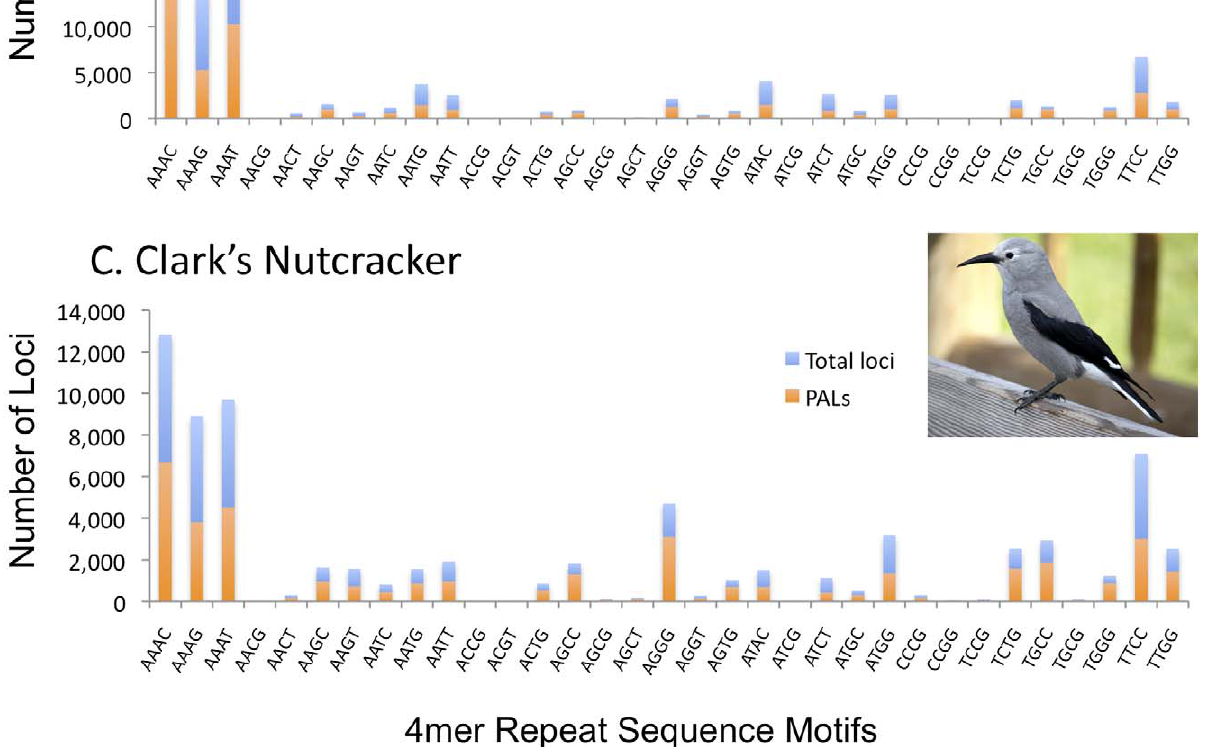
Figure 3. Comparison of microsatellite loci and ‘potentially amplifiable microsatellite loci’ (PAL) identification for 4mer repeat motifs in birds and the python. Results based on five million Illumina long (114–116 bp) paired-end reads per species.